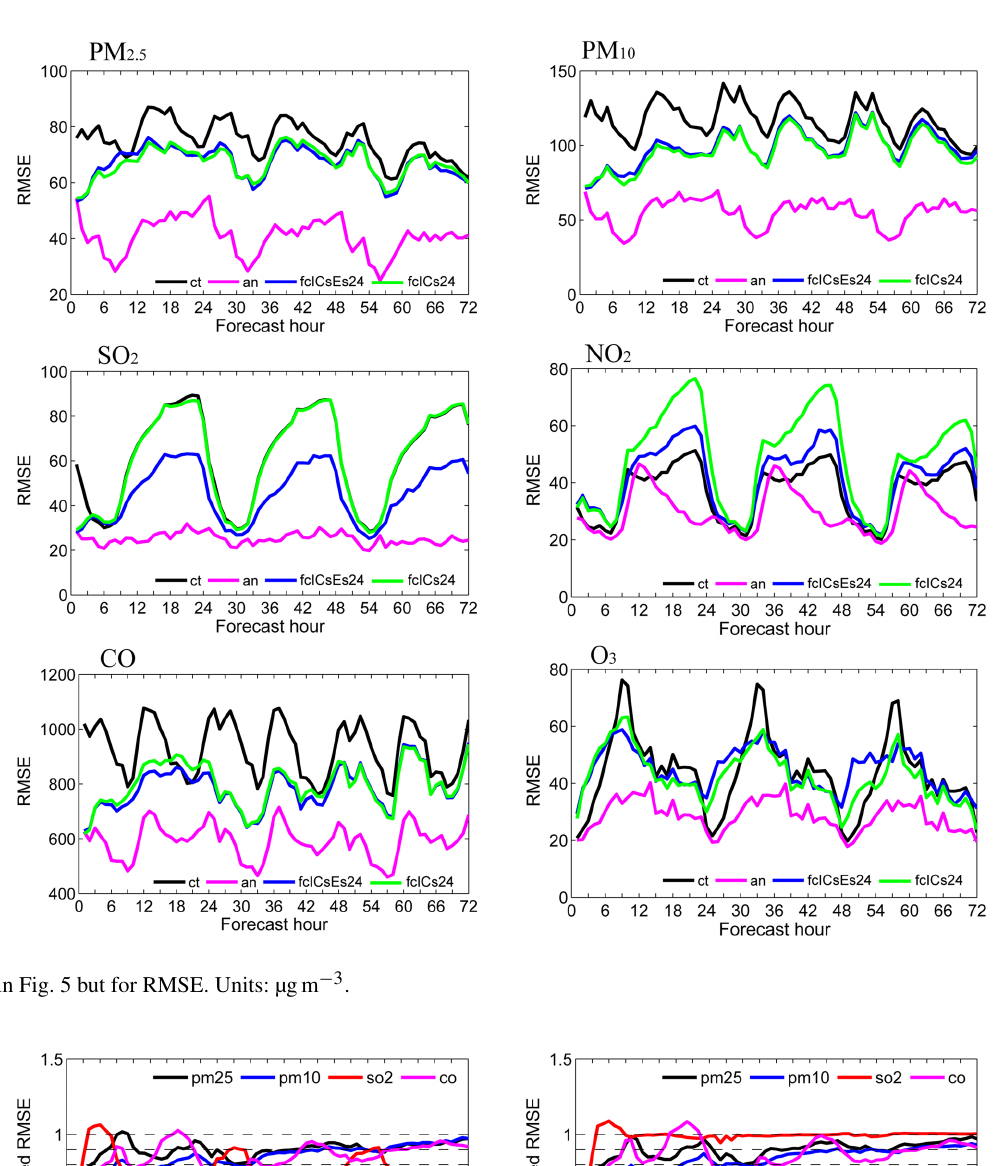
Figure 6. As in Fig. 5 but for RMSE. Units: µgm − 3 .